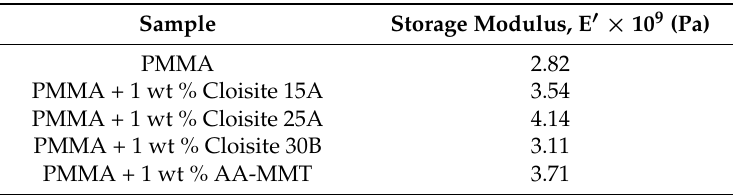
Table 2. Storage modulus E ′ of PMMA nanocomposites with different types of OMMT clay at 25 °C.